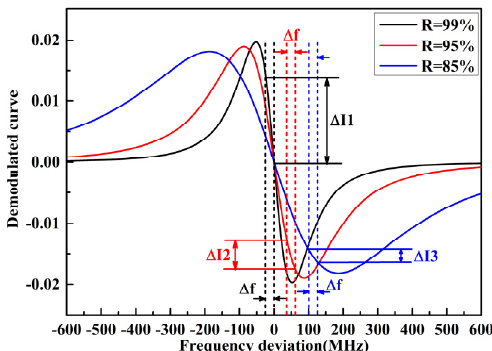
Figure 5. The simulation demodulated curves of the FPE with different reflectivity. With the phase modulation spectroscopy technology, the slope of the demodulated curve is connected with the phase modulation frequency as well. In light of the expressions of the output demodulated signal and its slope under sine wave modulation, the slope change characteristics of the FOAS based on the FPE with three different Q factors under different modulation frequencies, that is, the sensitivity change characteristics, can be obtained, as shown in Figure 6. As can be seen from Figure 6, with the decrease in reflectivity, the slope of the demodulated curve becomes smaller on the whole, indicating that the sensitivity of the FOAS will become smaller. Besides, the dynamic range is deter- mined by the minimum and maximum detectable sound pressure. The minimum detect- able sound pressure is related to the sensitivity. The greater the sensitivity, the smaller the minimum detectable sound pressure. The maximum detectable sound pressure is related to the sensitivity and linear amplitude of the demodulated curve. A smaller sensitivity and a larger amplitude of the demodulated curve can lead to a larger maximum detectable sound pressure. Although the sensitivity characteristics of the FOAS can be obtained via theoretical analysis, since the linear amplitude of the demodulated curve changes ran- domly, the maximum detectable sound pressure performance of the FOAS needs to be further measured experimentally.